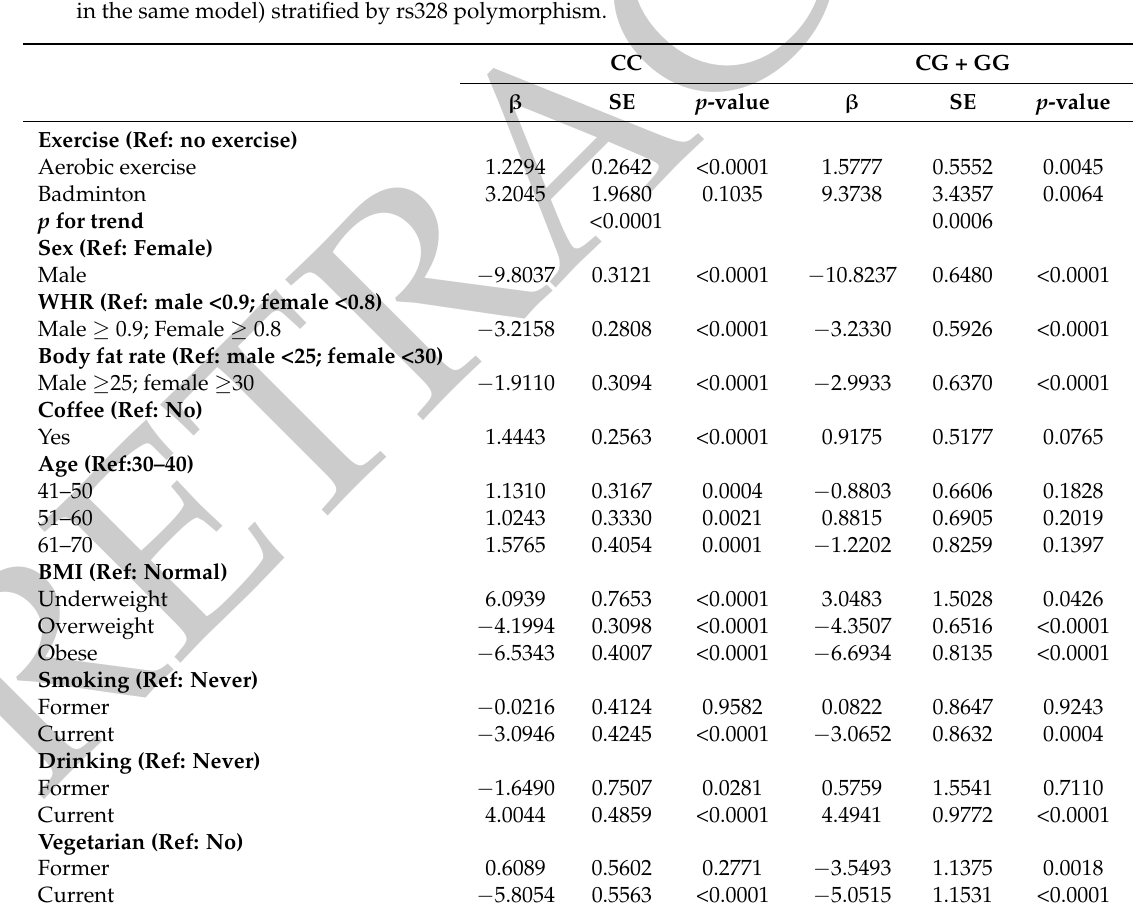
Table 4. Association between HDL-C and exercise type (aerobic exercise and badminton are included in the same model) stratified by rs328